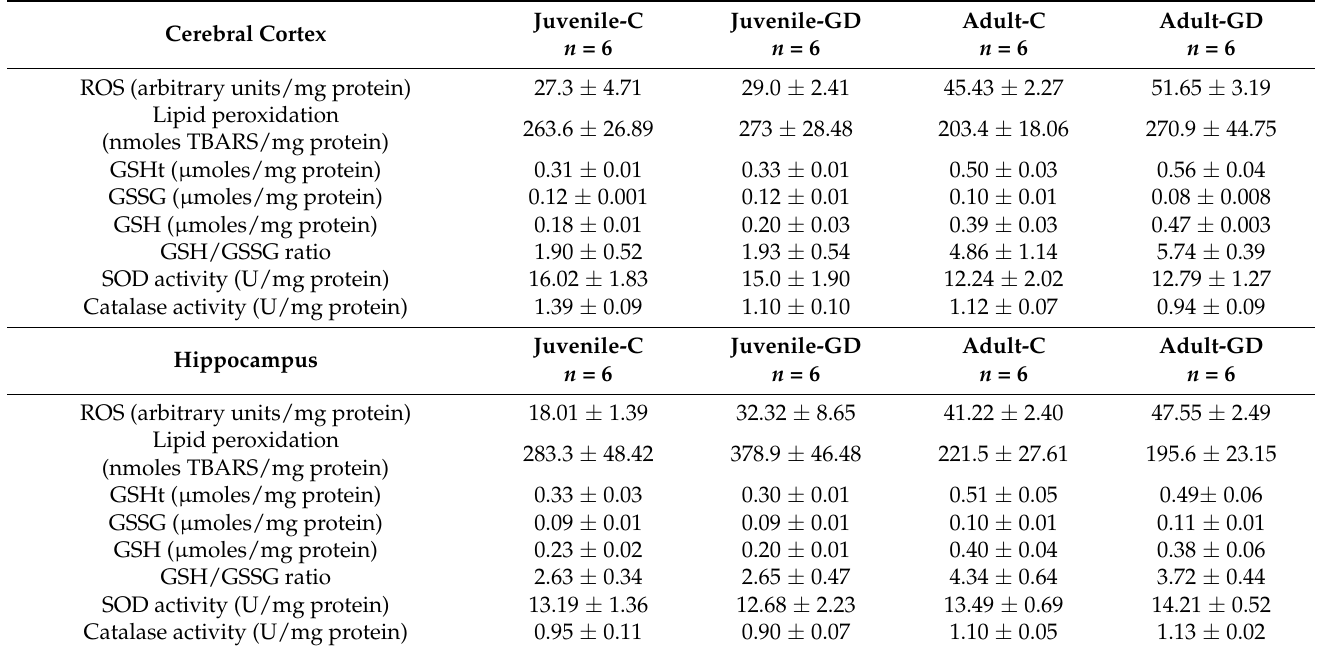
Table 2. Oxidative stress biomarkers of male second-generation offspring.